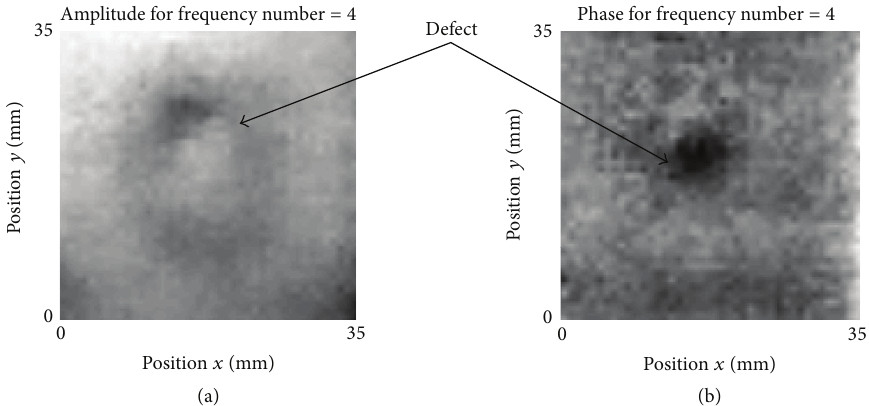
Figure 5: Selected results of thermographic inspection: (a) amplitude image AmpIRT 4 (𝑥,𝑦) and (b) phase image PhaIRT 4 (𝑥, 𝑦) obtained using halogen lamps heating system.